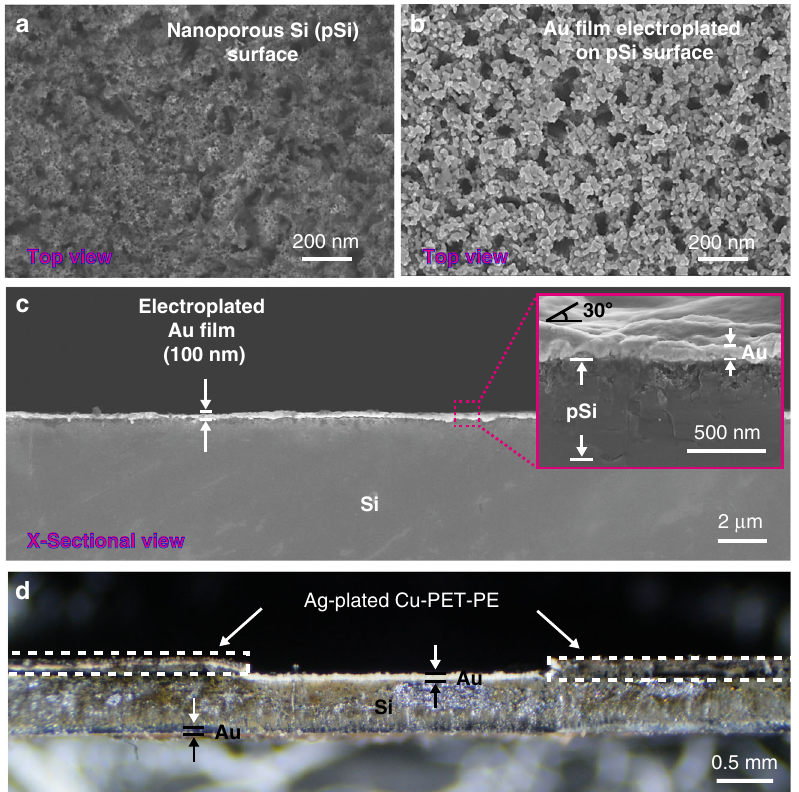
Fig. 2 Scanning electron micrographs. a Surface of Si wafer after metal-assisted chemical etching with Au catalyst producing a nanoporous Si surface (pSi). b pSi surface after electroplating with gold. c Cross-section of the sample shown in ( b ). The inset is a close-up view of the cross-section where the Au and porous Si layers are clearly visible. d Optical micrograph of the cross-section of a TriSilix Chip with thermally bonded sheets of polymer fi lms. Note that while the cross-sectional image shown in ( c ) was cleaved, ( d ) was laser-cut hence the